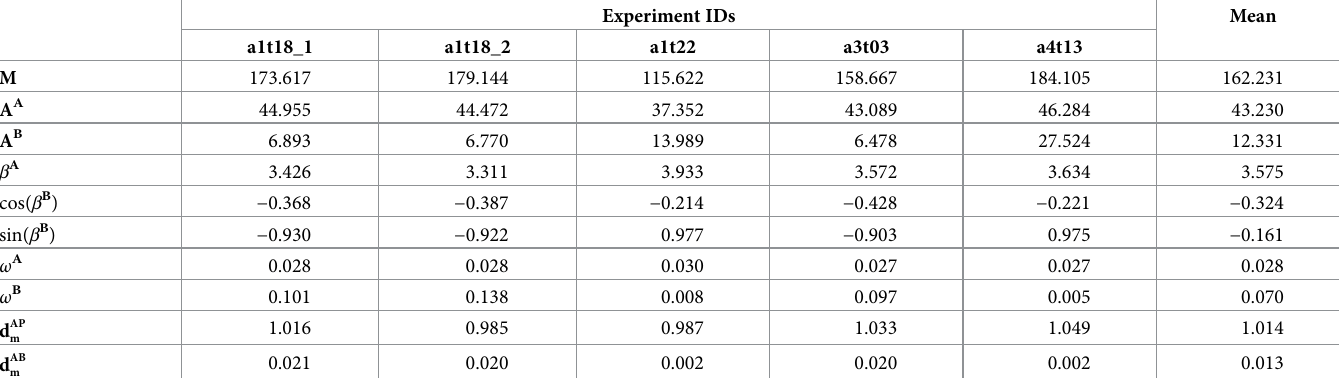
Table 7. Parameter estimators of the FMM ST � models for the SGAMP signals.